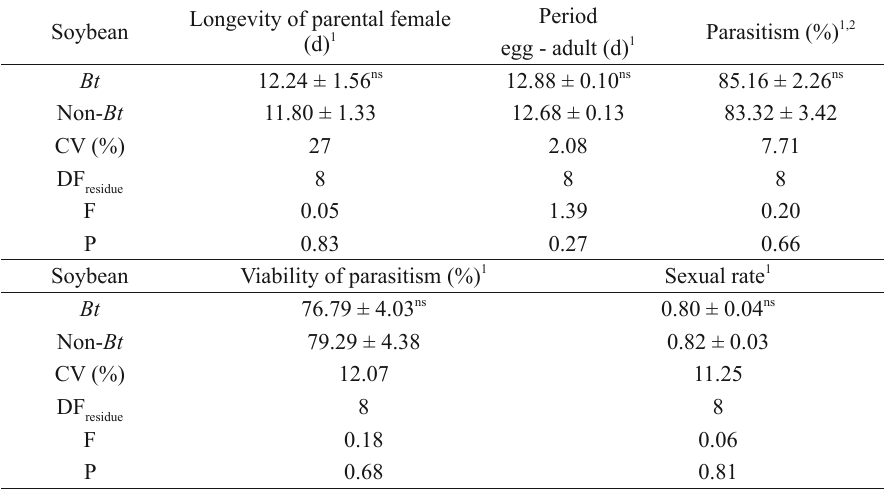
Biological parameters of Telenomus podisi developed in Dichelops melacanthus eggs fed on Bt and non Bt